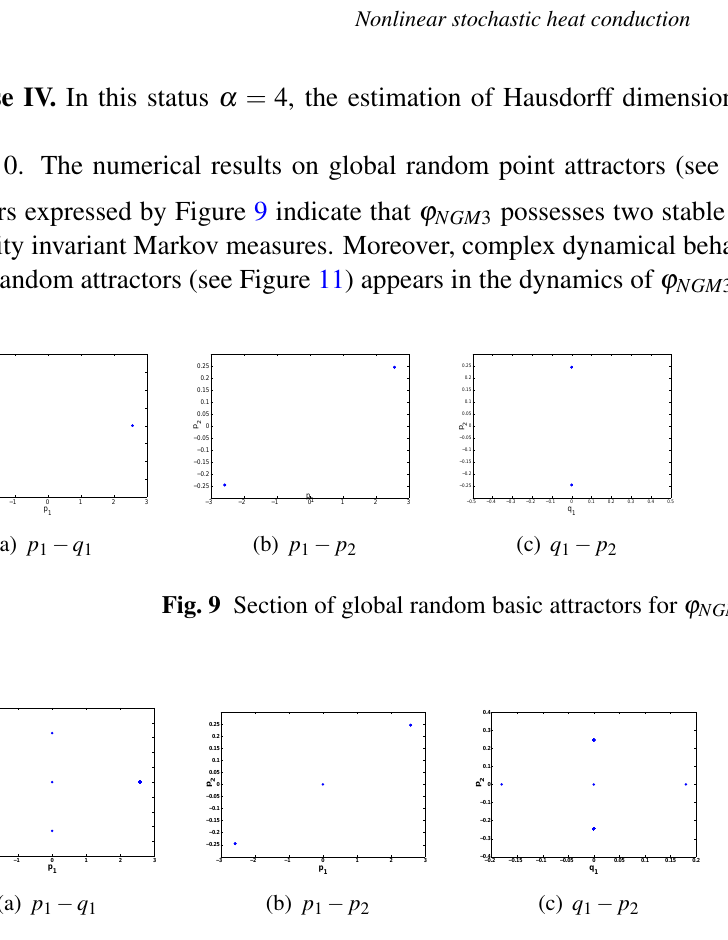
Fig. 10 Section of global random point attractors for ϕ NGM 3 with case IV